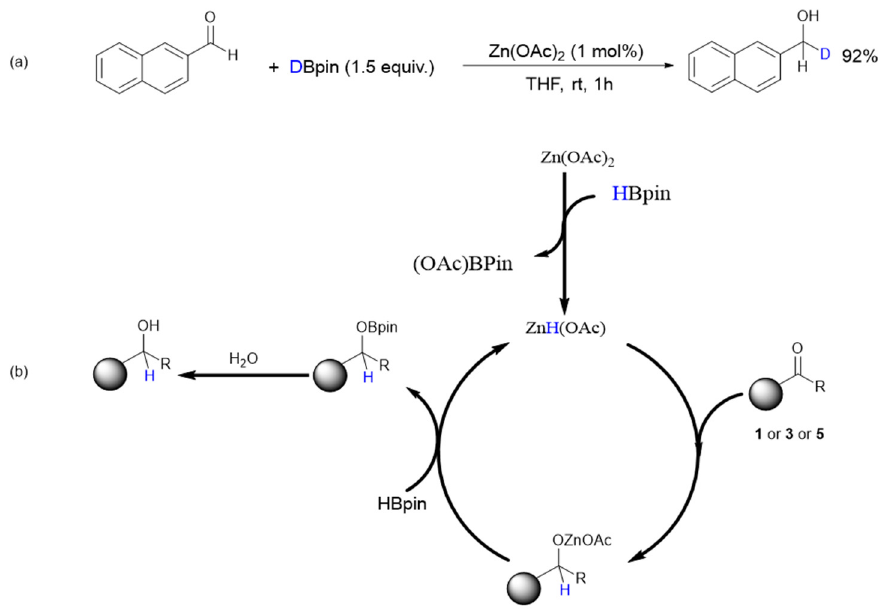
Figure 2. Plausible mechanism for the hydroboration of carbonyl compounds: ( a ) control experiment; ( b ) proposed mechanism for the Zn-catalyzed regioselective and chemoselective reduction of aldehydes, ketones and α , β -unsaturated aldehydes/ketones.